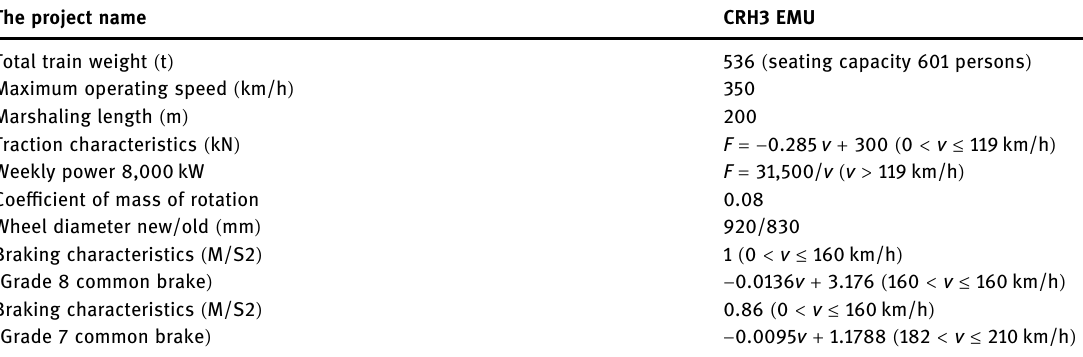
Table 2: Main parameters and characteristics of CRH3 EMU The project name